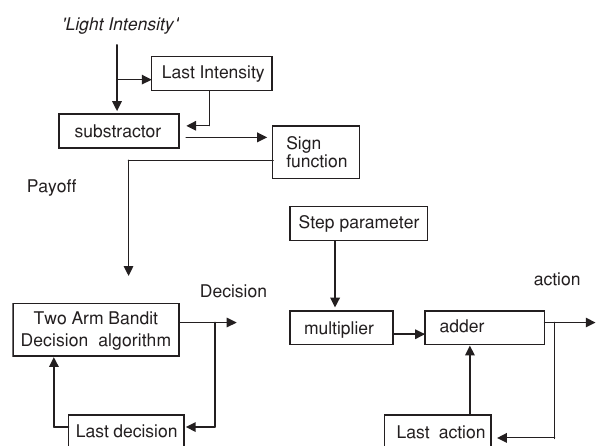
Figure 1 Body and motors. Denotation of servos and parts. Figure 2 Implementation of a generic SIM module. The module has an ad hoc hardware part and a software part.